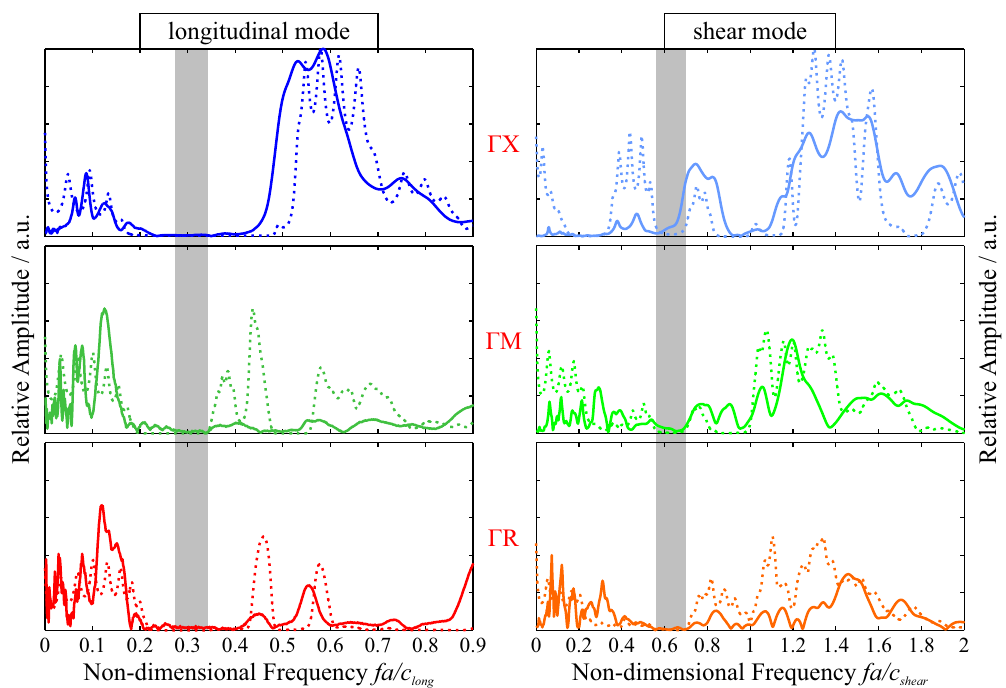
Figure 8. Normalized acoustic transmission for circular holes design Figure 1a in characteristic directions Γ X, Γ M, and Γ R for longitudinal waves [31] and shear waves. Dotted lines indicate simulated transmission through a semi-infinite lattice, and shaded areas indicate the regions of the complete band gap of an infinite